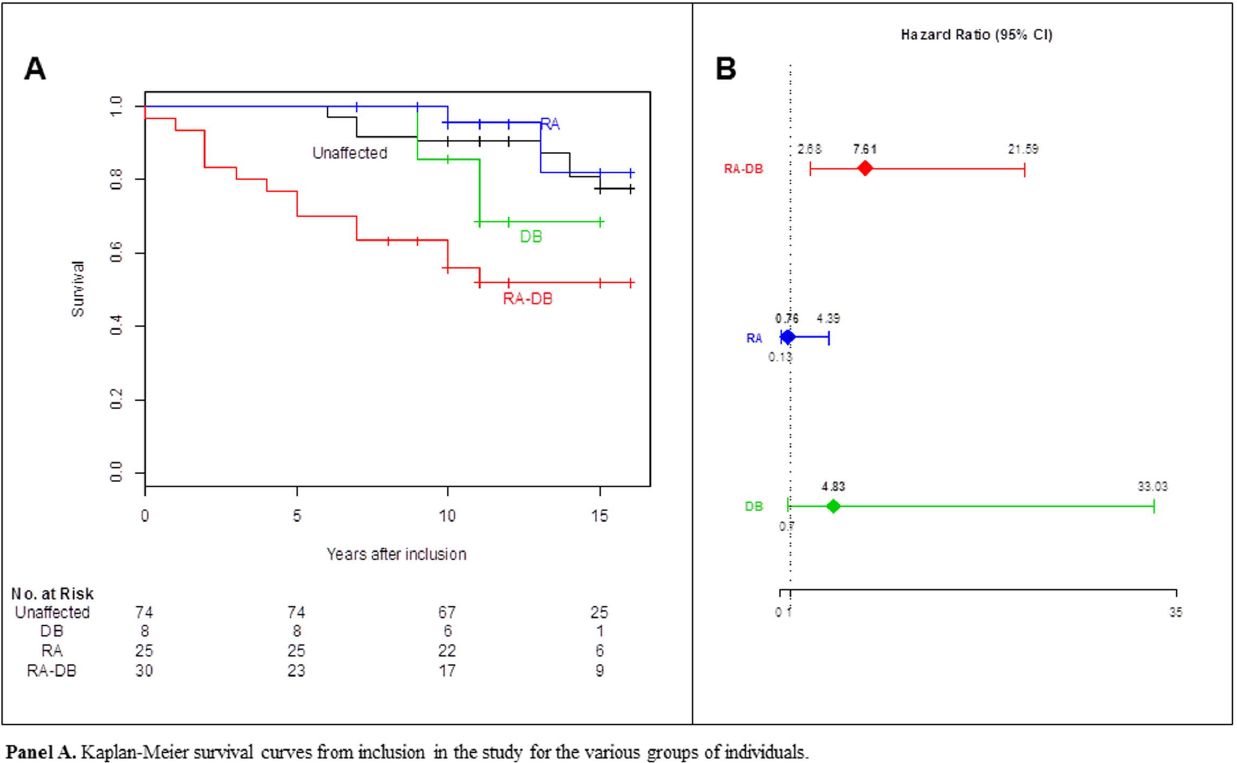
Figure 1. Kaplan-Meier probability of survival from inclusion of the various participants in the study cohort, according to their phenotype. Panel A. Kaplan-Meier survival curves from inclusion in the study for the various groups of individuals. Panel B. Hazard ratios (95% CI) of death after inclusion for the various disease groups, compared with unaffected relatives as the reference group. A mixed effect Cox model was fitted, taking inclusion as the starting point and adjusting for age at inclusion. Individual random effects were assumed to be correlated as a function of the corresponding kinship coefficients. The variance of the random effect was 1.48. RA: rheumatoid arthritis; DB: diffuse bronchiectasis.